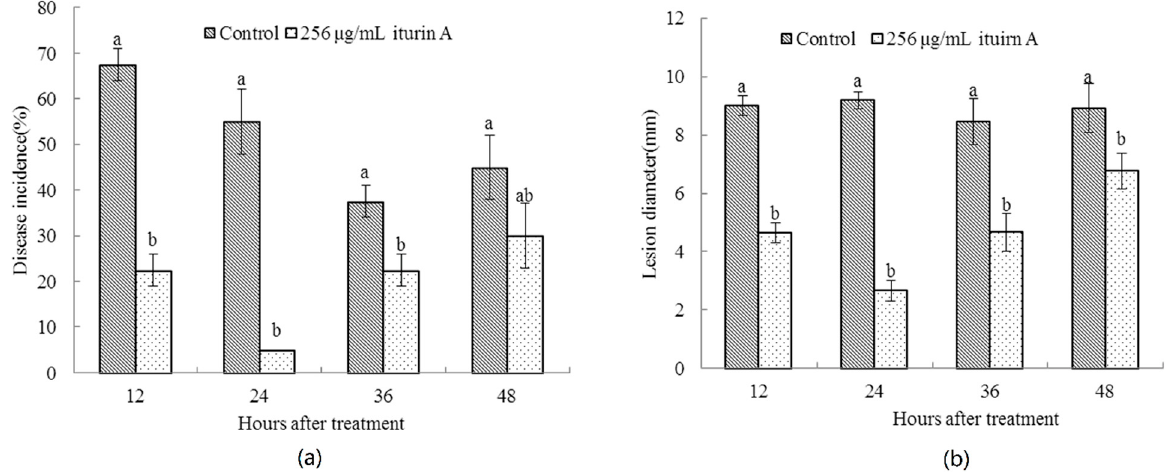
Figure 1. Effects of treatment time of iturin A on soft rot incidence ( a ) and lesion diameter ( b ) of cherry tomato fruit. Error bars represent standard errors of three replicates. Significant differences ( p < 0.05) were shown by different letters on each column based on Duncan’s multiple range test.